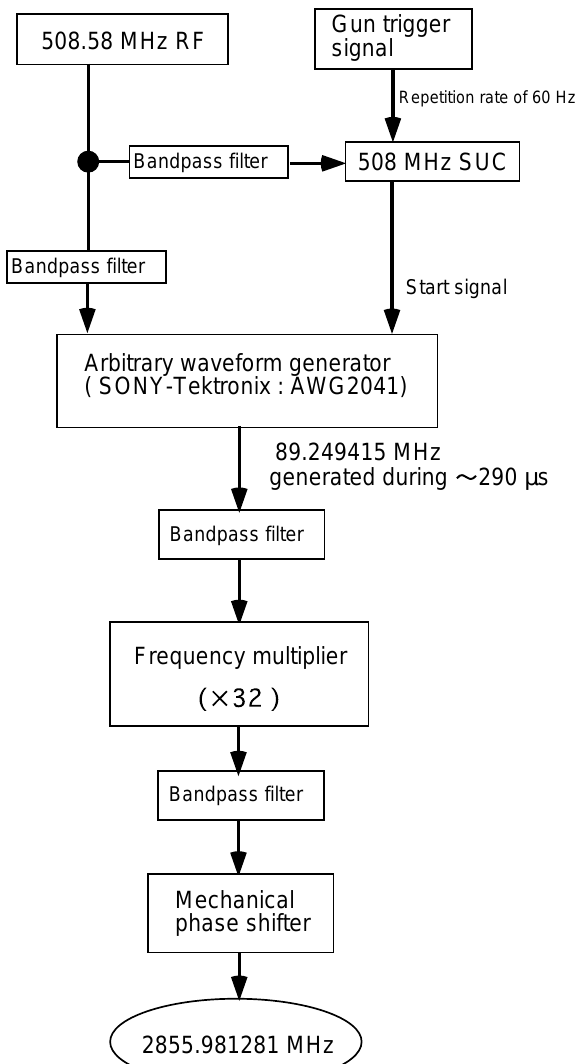
FIG. 1. Block diagram of the new synchronization method be- tween the 508.58 and 2856 MHz rf’s. The system consists of an arbitrary waveform generator and a frequency multiplier. The 2856 MHz rf is generated only for a short duration of about 290 m s.